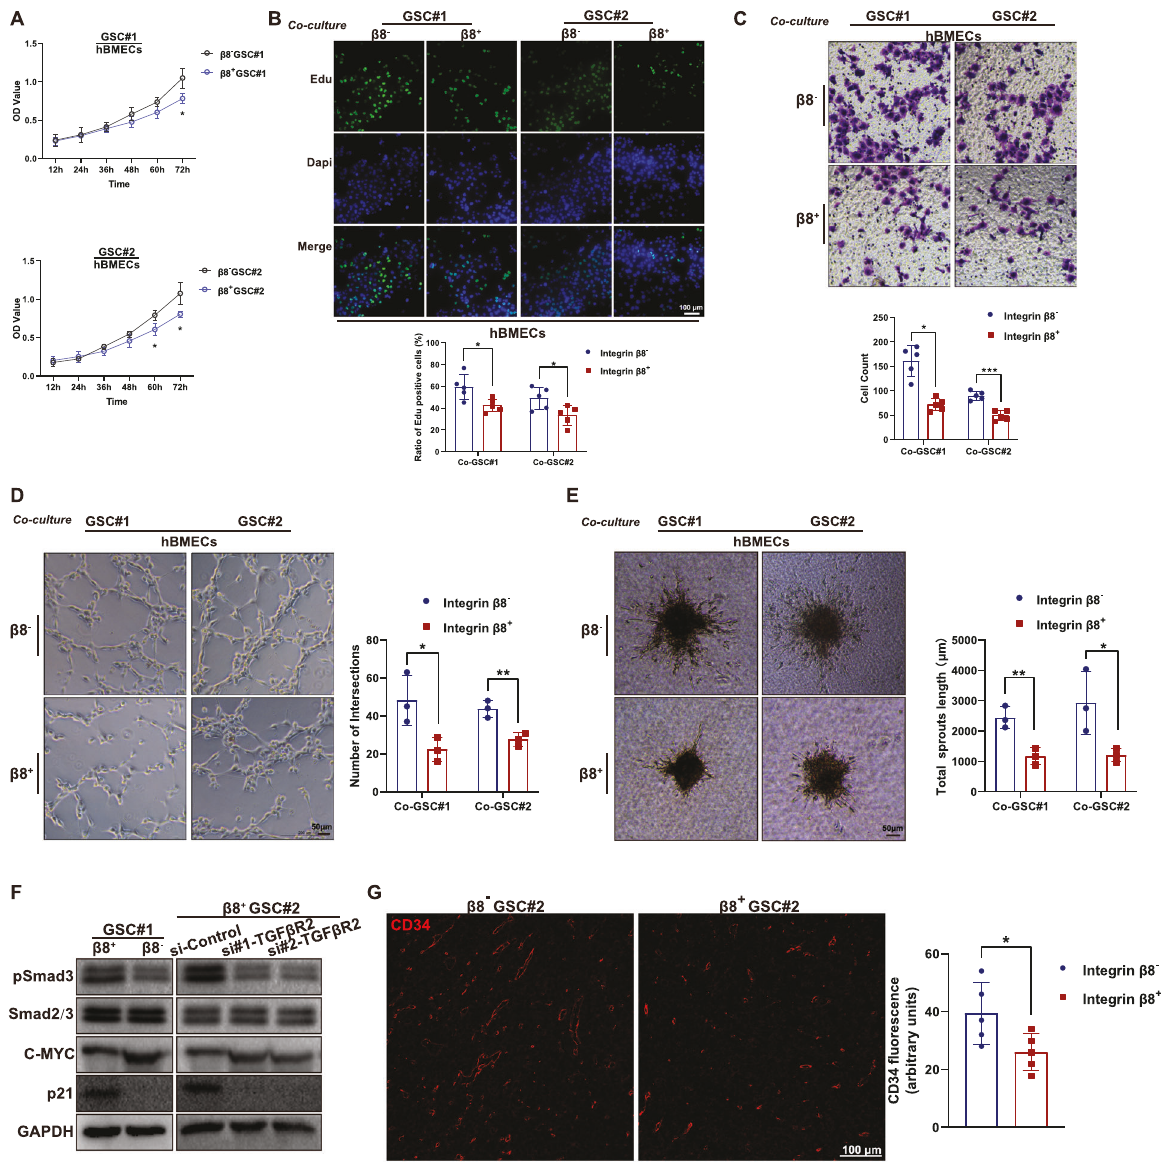
Fig. 3 GSCs-derived β 8 integrin expression inhibits angiogenic capacity of human brain microvascular endothelium. A hBMECs were co- cultured with β 8 − or β 8 + GSCs for 24 h, cell proliferation was determined via CCK-8 assay. B hBMECs co-cultured with β 8 − or β 8 + GSCs were subjected to Edu staining. Scale bar = 100 μ m. C Migration assay was conducted of hBMECs that co-cultured with β 8 − or β 8 + GSCs. D Tube formation assay on Matrigel was performed of hBMECs that co-cultured with β 8 − or β 8 + GSCs. Scale bar = 50 μ m. E hBMECs were co-cultured with β 8 − or β 8 + GSCs. Spheroid-based angiogenesis assay was performed. F The protein levels of phosphorylated Smads, c-Myc and p21 in hBMECs cultured with β 8 − or β 8 + GSC#1 (left panel). Indicated proteins in hBMECs treated with scrambled siRNA or siTGF β R2, followed by co- culture with GSC#2. G Orthotopic xenografts GBM model was established with β 8 − or β 8 + GSC#2. Sections of fi ve random mice of each group were selected and immuno fl uorescence stained for CD34. Scale bar = 100 μ m. Uncropped western blot images are shown in Supplementary Fig. 5. Results are represented as mean ± SD of biologically triplicate assays. * p < 0.05, ** p < 0.01, *** p <